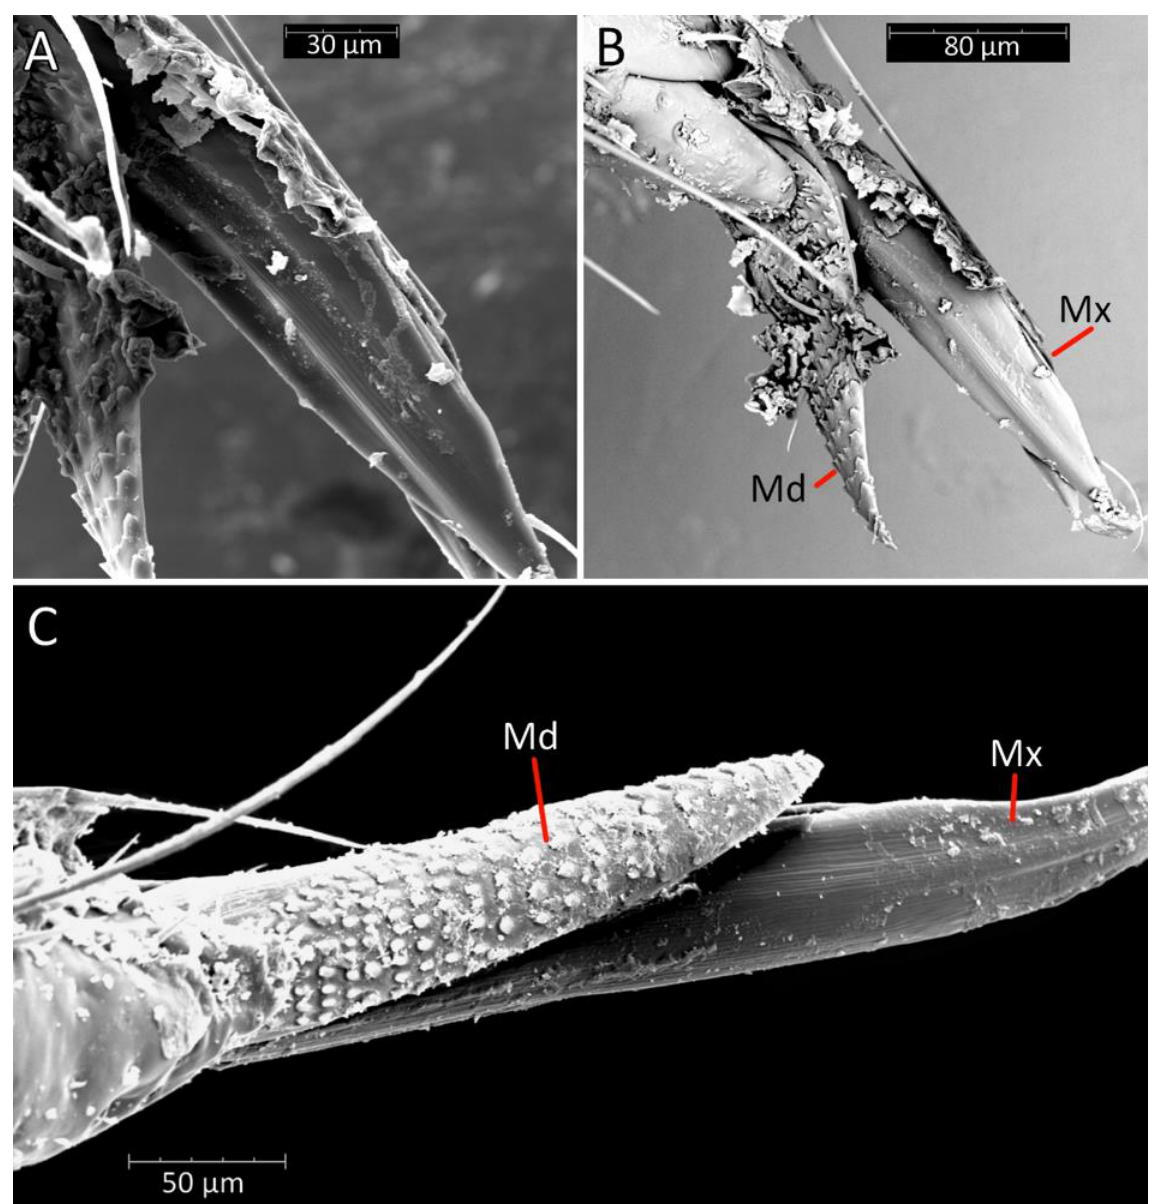
Figure 13. ( A-C ) Mandibular stylet ( Md ) and maxillary stylet ( Mx ) of Phonoctonus fasciatus (Beauvois, 1805). Anterior lobe of the pronotum is relatively small and distinctly narrower than the posterior lobe of the pronotum (Figures 3F and 16). Anterior lobe has a distinct longitudinal groove. Collar of the anterior lobe is very distinct with various sized calli (Figure 8). Apices of calli are directed laterally (Figure 8). Margins of the anterior and posterior lobes of the pronotum have short and dense setae. Posterior lobe is two times longer than the anterior lobe. Humeral angles of the pronotum are rounded. Posterior pronotal extensions are clearly visible (Figures 1, 3F and 17A). On the underside of the posterior pronotal lobe, on the edge of posterior pronotal extensions, bunches of sensilla are located—probably sensilla trichoidea (Figure 17B,D). Posterior lobe has a delicate and wide depression between posterior pronotal extensions. Scutellum has a medial depression and Y-shaped calli (Figure 1); lateral margins of scutellum are covered by dense, medium-sized